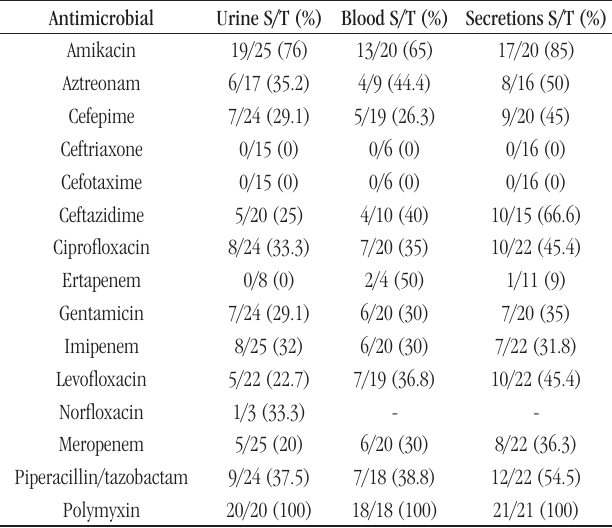
taBLE 5 − Susceptibility profile of Pseudomonas aeruginosa isolated from different clinical specimens in antimicrobial